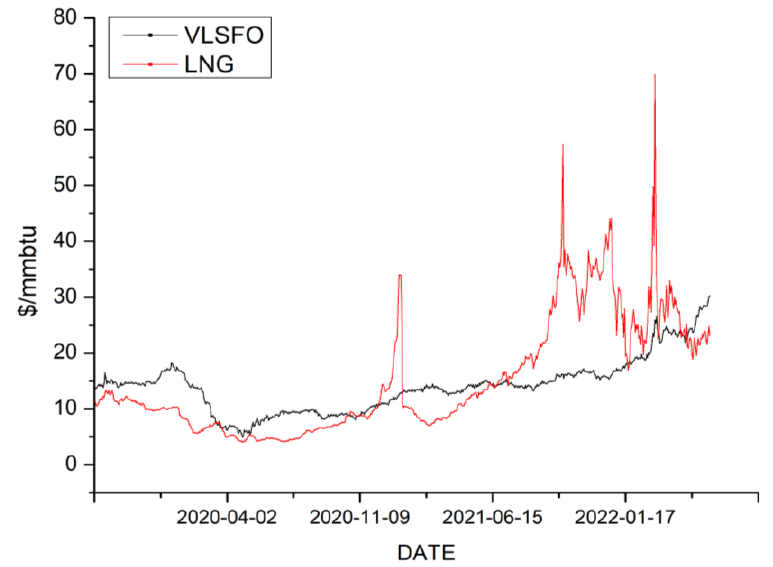
Figure 2. LNG bunker price trend in the port of Singapore (computed by the authors using data from Platts Bunkerwire [6]). LNG, liquefied natural gas; VLSFO, very low sulfur fuel oil.